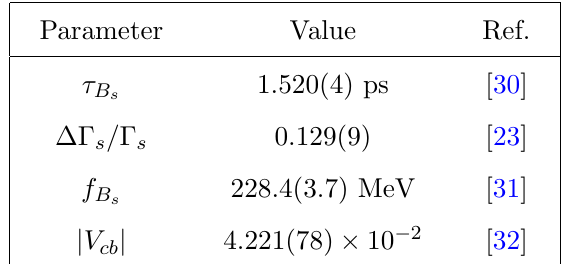
Table 1 . Numerical inputs for the SM calculation of BR( B of 50 fb (cid:0) 1 [33], corresponding to their expectation for LHC Run 4, while CMS expects a precision of 0 : 4 10 (cid:0) 9 for 3000 fb (cid:0) 1 [34], corresponding to their expectation for Run (cid:2)